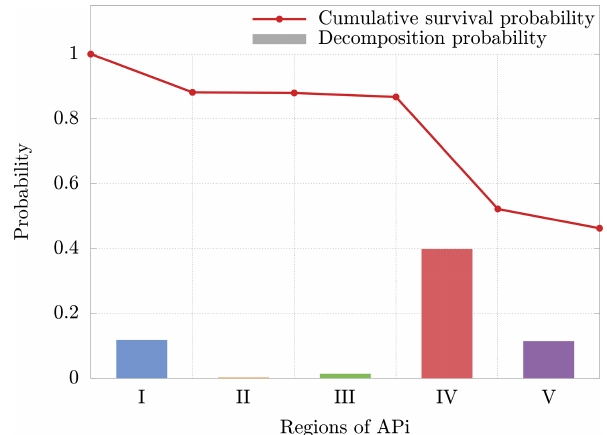
Figure 8. (a) Average number of total and fatal collisions per realization of cluster evolution in the different APi regions. (b) Ratio between total and fatal collisions. The results have been obtained from 5000 realizations of ( HSO − regions’ lengths of the APi are different; in particular region IV, where the quadrupole is located, is much longer than the other regions, which leads to a higher number of collisions.